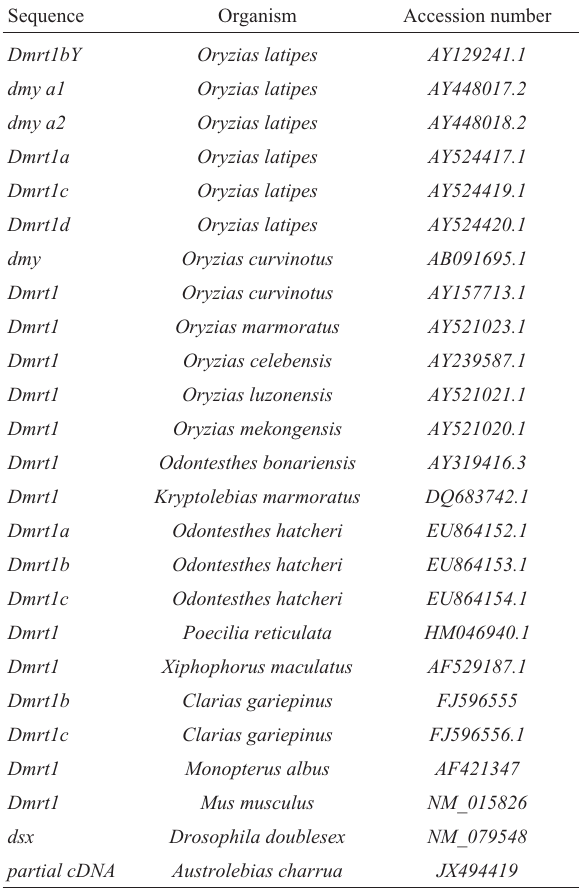
Table 3 - Dmrt1 and doublesex gene sequences obtained from GenBank and the expressed partial cDNA sequence isolated from Austrolebias charrua